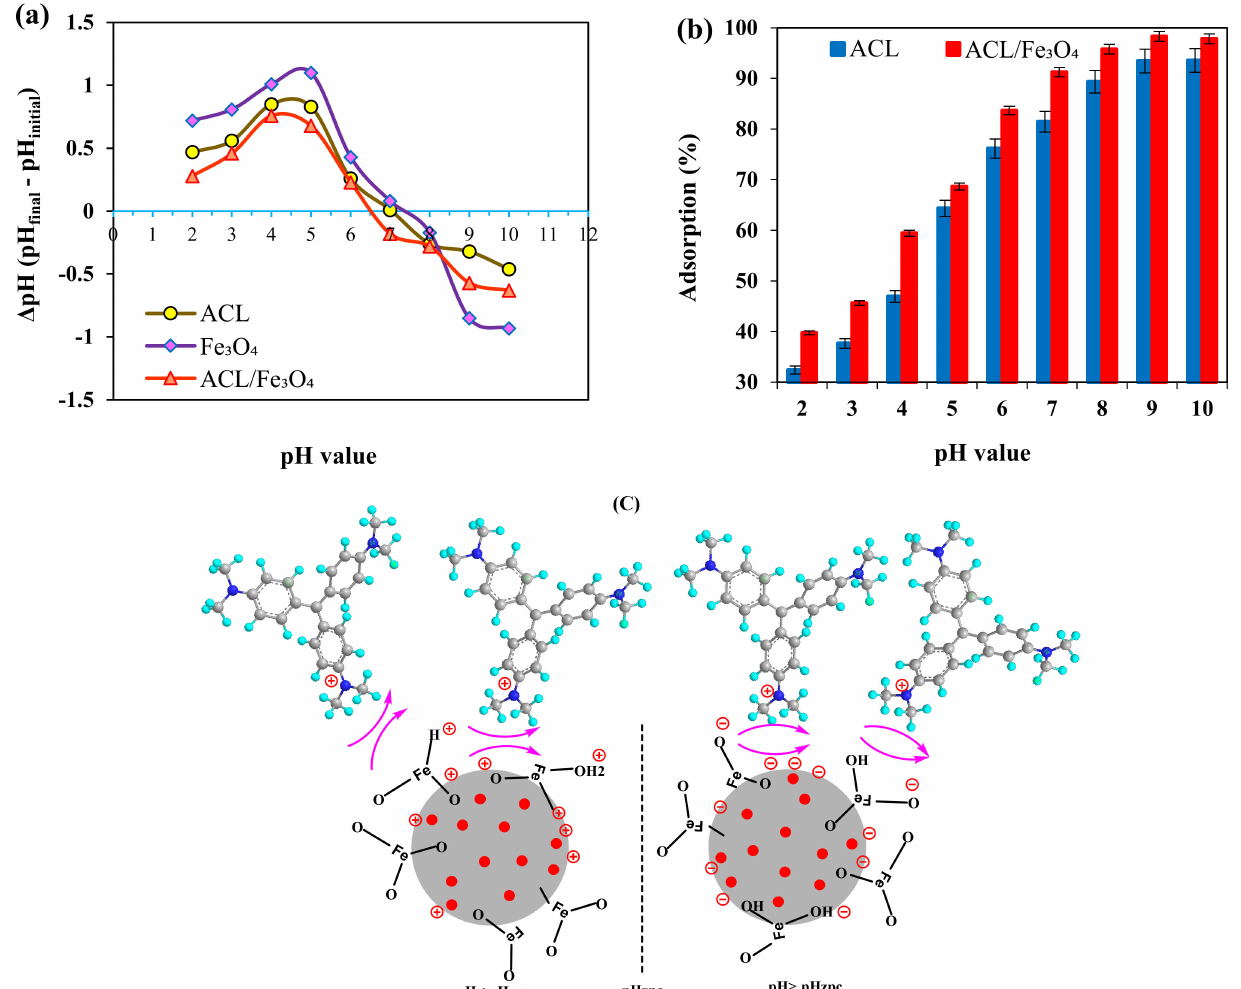
Figure 4. ( a ) The effect of pH on the surface loads of adsorbents; ( b ) The effect of pH on the efficiency of the adsorption process (temperature 25 ◦ C, contact time 60 min, adsorbent dose 1.25 g/L, CV dye concentration 10 mg/L), and ( c ) the mechanism of the CV dye adsorption process in the acidic and alkaline pH